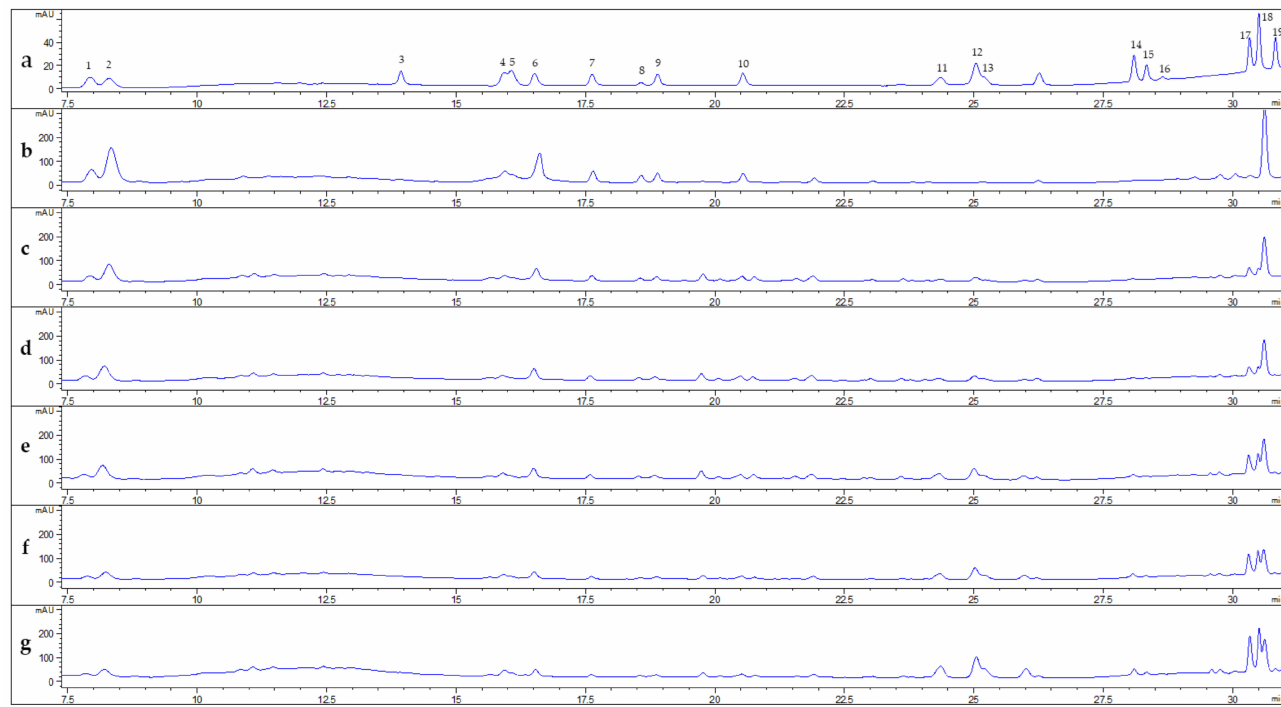
Figure 3. HPLC chromatograms of puffed CRMG: ( a ) Standard; ( b ) Control; ( c ) 196.1 kPa; ( d ) 294.2 kPa; ( e )392.3 kPa; ( f ) 490.3 kPa; ( g ) 588.4 kPa. Peaks: 1, Rg1; 2, Re; 3, Rf; 4, Rg2; 5, Rh1; 6, Rb1; 7, Rc; 8, Rb2; 9, Rb3; 10, Rd; 11, Rg6; 12, F4; 13, Rk3; 14 and 15, 20 (S)- and 20 (R)-Rg3; 16, PPT; 17, Rk1; 18, Rg5; 19, Rh2. Table 3. PPT-type ginsenoside contents of puffed CRMG ginsenoside contents (mg/g DW). Puffed